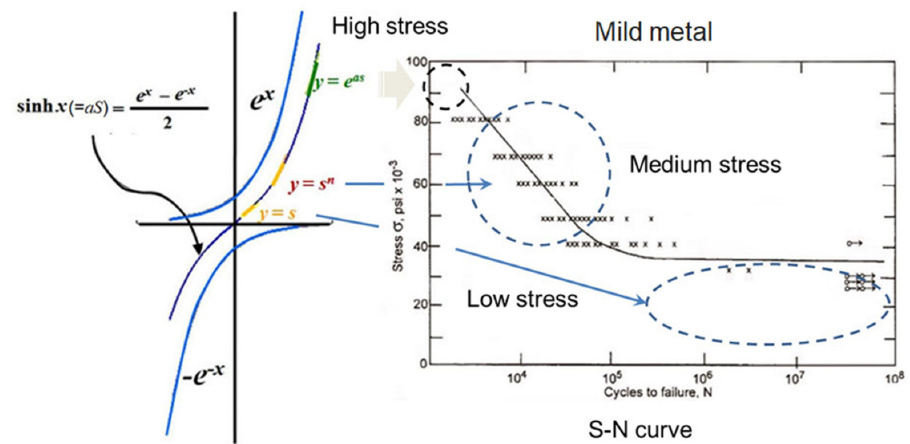
Figure 6. Hyperbolic sine stress term versus S-N curve from a standpoint of stress range.